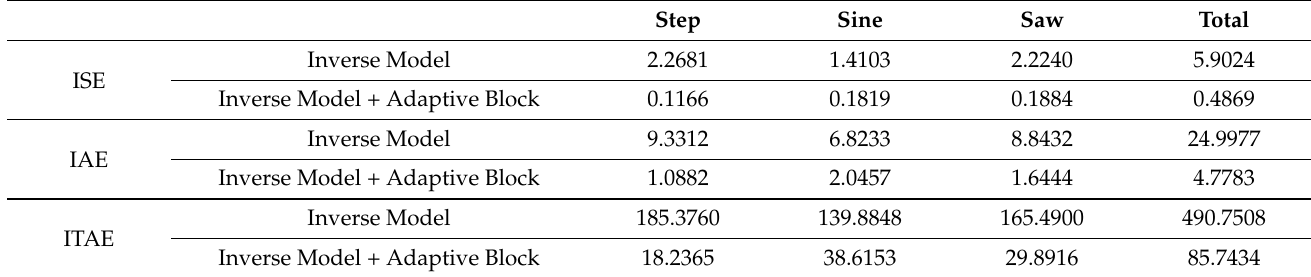
Table 9. Integral Square Error (ISE), the Integral Absolute Error (IAE), and the Integral Time Absolute Error (ITAE) values for the inverse model controllers.